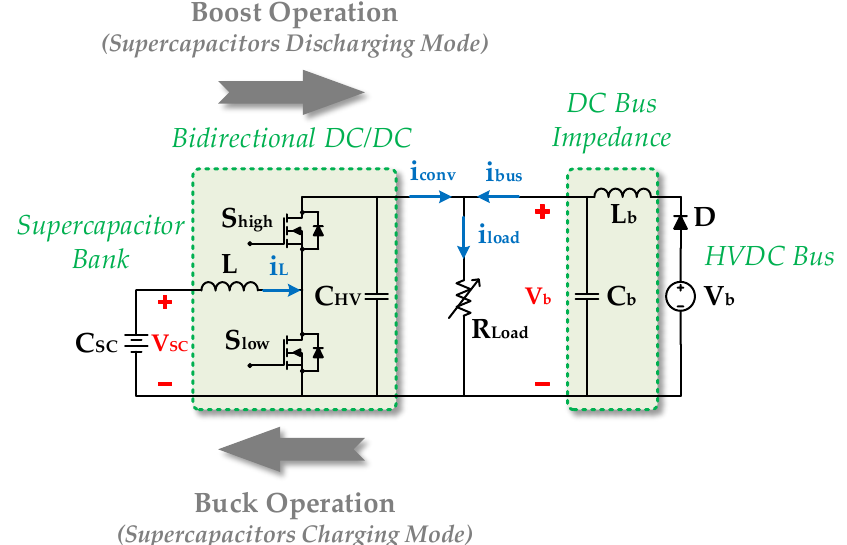
Figure 4. Schematic diagram of the proposed system and the test bench, used for simulation and experimental evaluation.